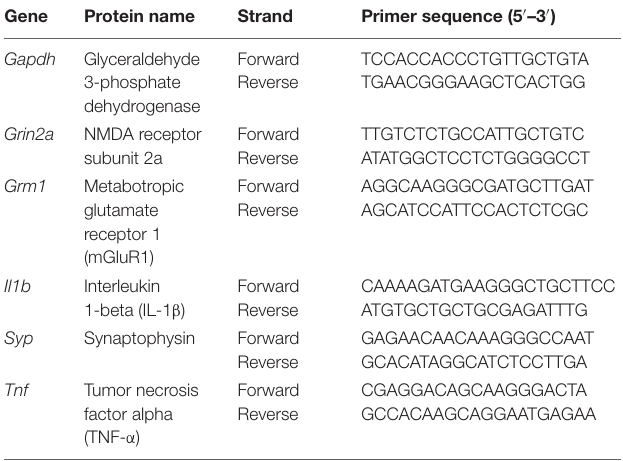
TABLE 1 | SYBR green qPCR primer